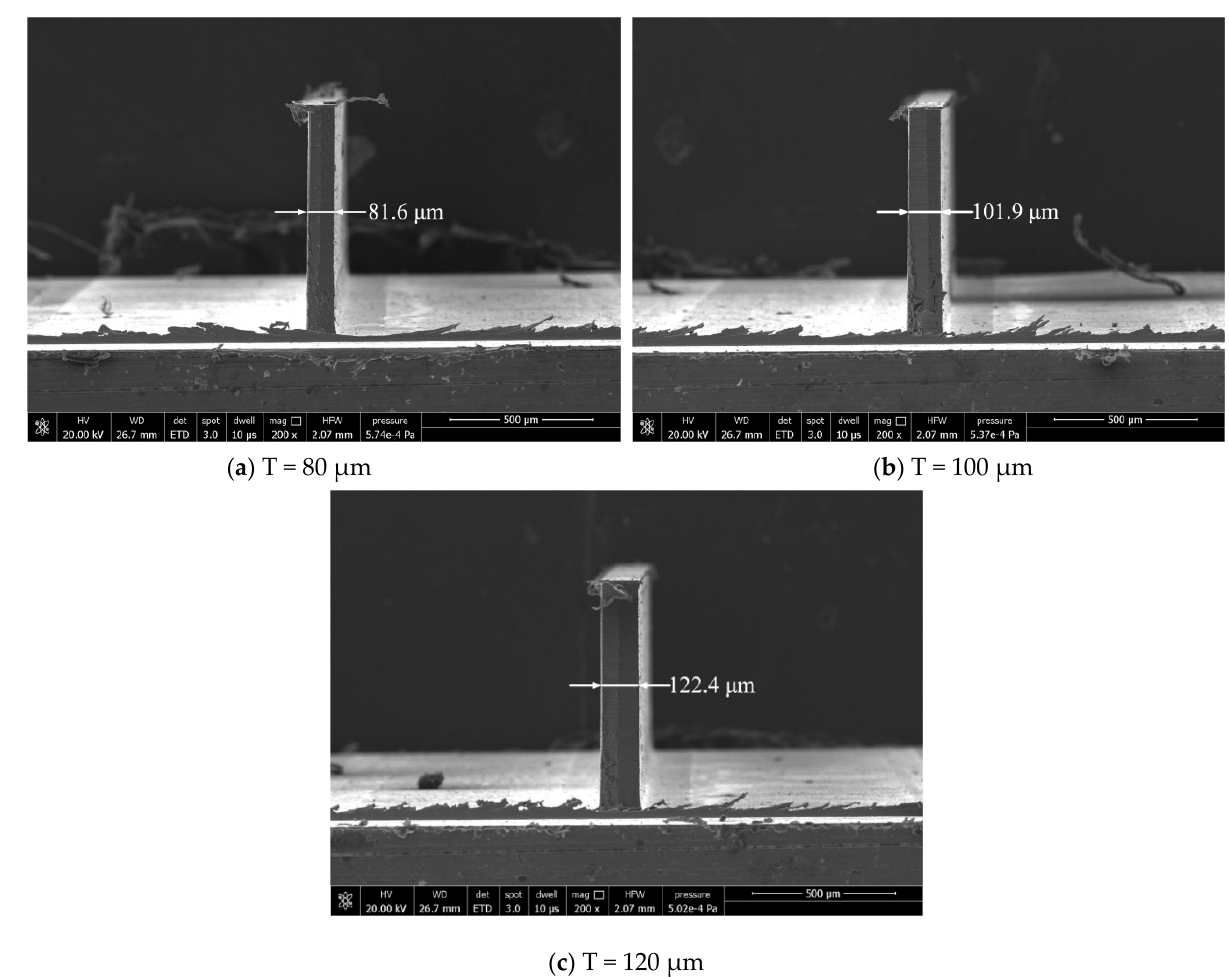
Figure 12. Results with radial cutting parameter compensation.